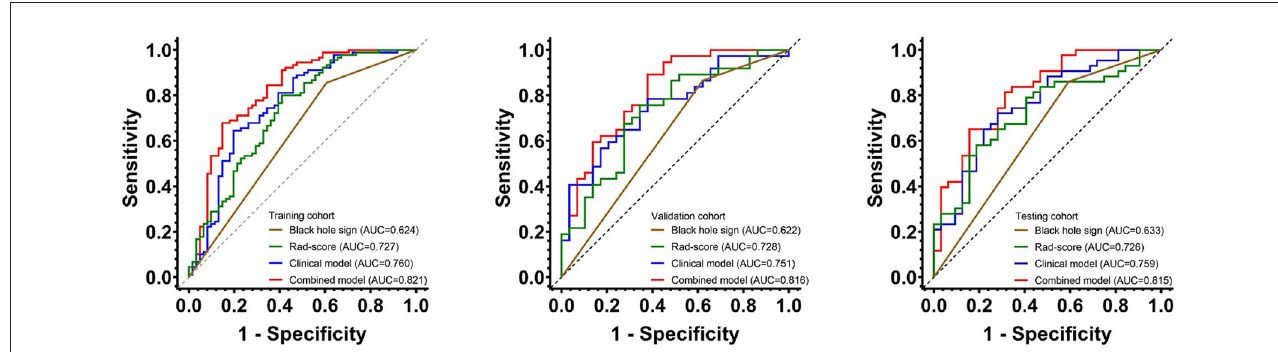
FIGURE3 The receiver operating characteristic curves of the black hole sign, Rad-score model, clinical model, and combined model for assessing the 30-day clinical functional outcomes in the training, validation, and testing